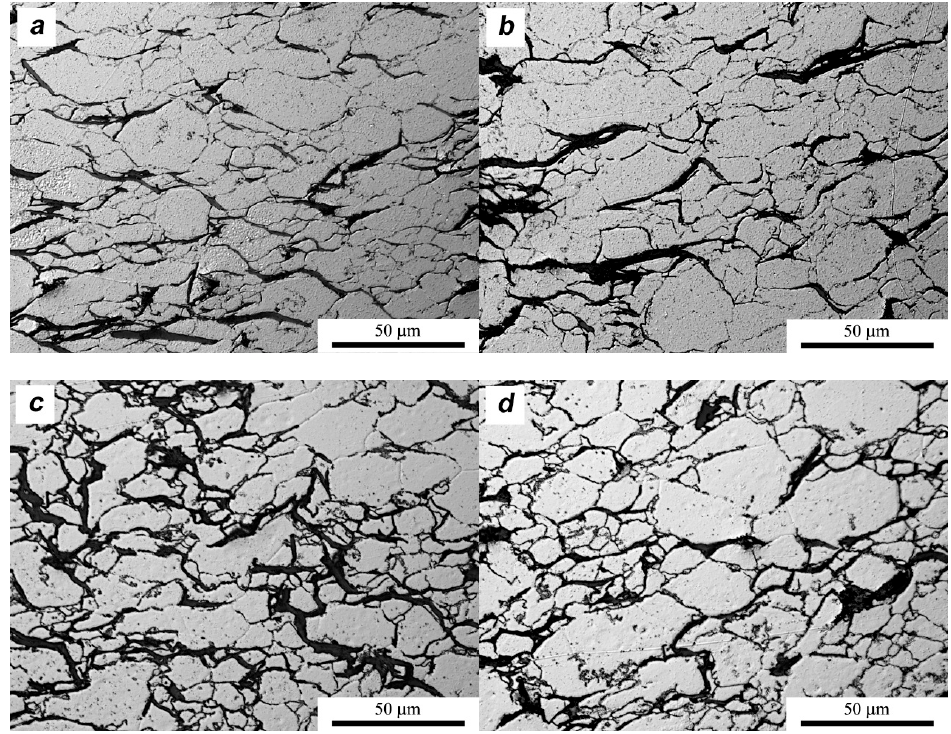
Figure 15. Microstructure of SPT samples AA6061/MLG 10 vol %: ( a ) center area λ = 1.5; ( b ) edge area λ = 1.5; ( c ) center area λ = 2; ( d ) edge area λ = 2.